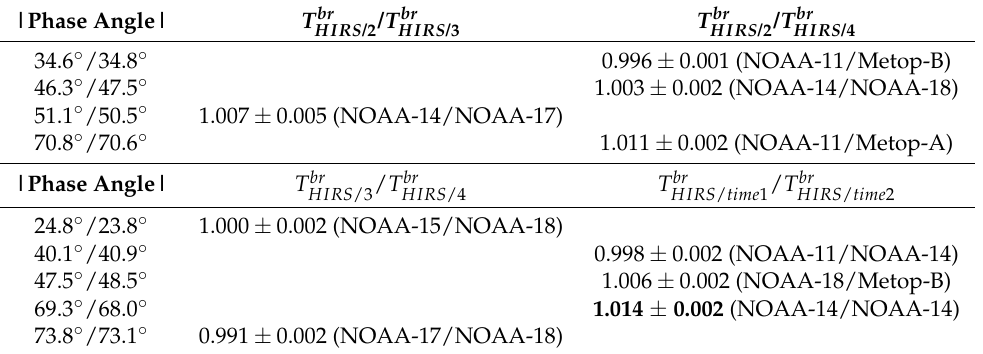
Table 2. Ratio of the average brightness temperature T br of the Moon as measured with the long-wave channels 1-12 of HIRS on different satellites. This ratio would be one for perfect instruments. The uncertainties reflect the random scatter of the ratios among the different channels. The first column gives the absolute value of the phase angles of the Moon; the pairs were chosen just so these angles are almost the same for either measurement. The value in bold face refers to the only pair, where both measurements were made with the same instrument on the same satellite, but at different times. It is also the only pair, where the measurements were made close to minimum and maximum distance between the Sun and the Moon, which explains the large ratio.